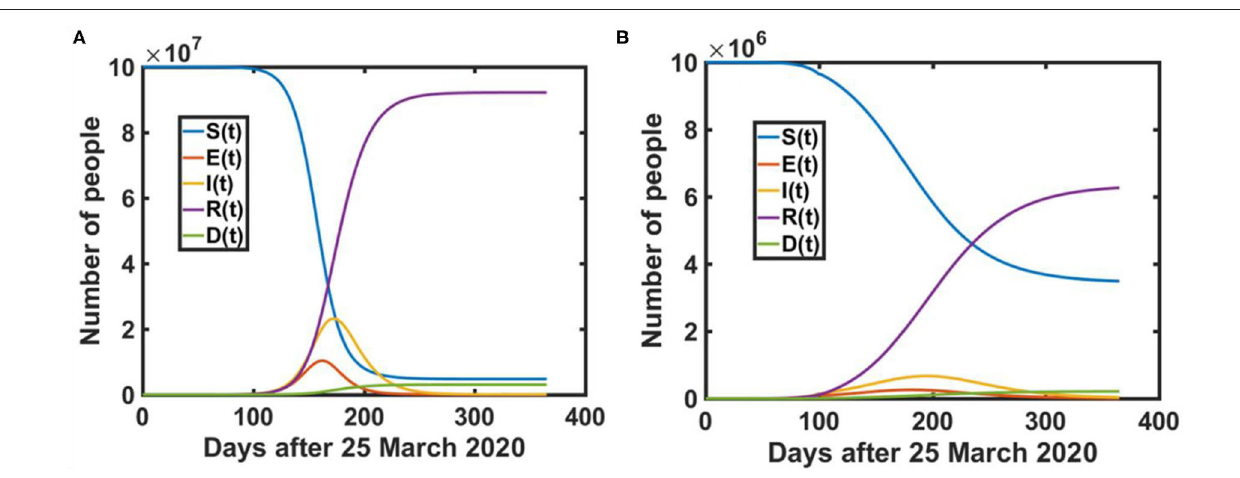
Frontiers in Physics |